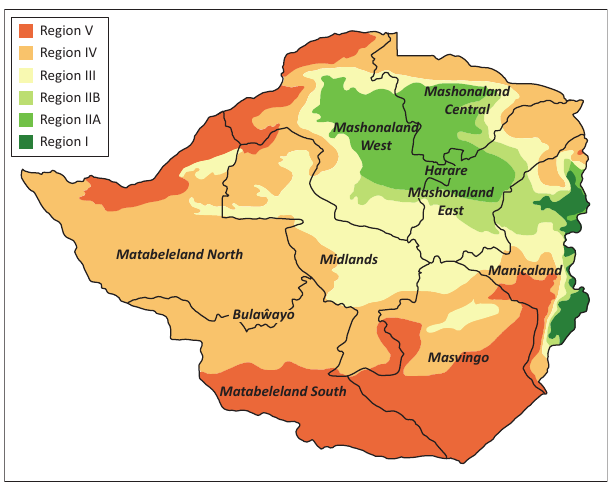
Source : Brazier, A., 2017, Climate change in Zimbabwe. A guide for planners and decision makers , 2nd edn., Konrad-Adenauer-Stiftung, Harare FIGURE 1: Zimbabwe’s agro-ecological